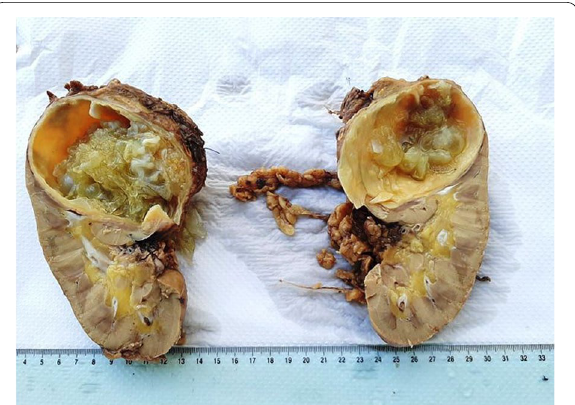
Fig. 2 Macroscopic findings: renal cyst (9 multiple internal smaller cysts recalling the appearance of the hydatid